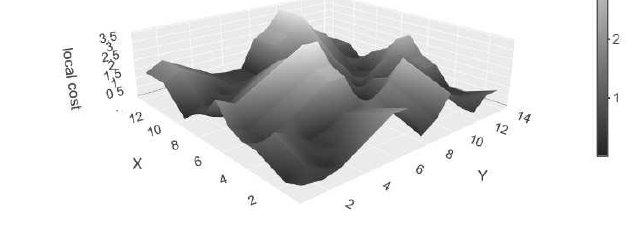
Figure 3. Local cost matrix of the time series X and Y